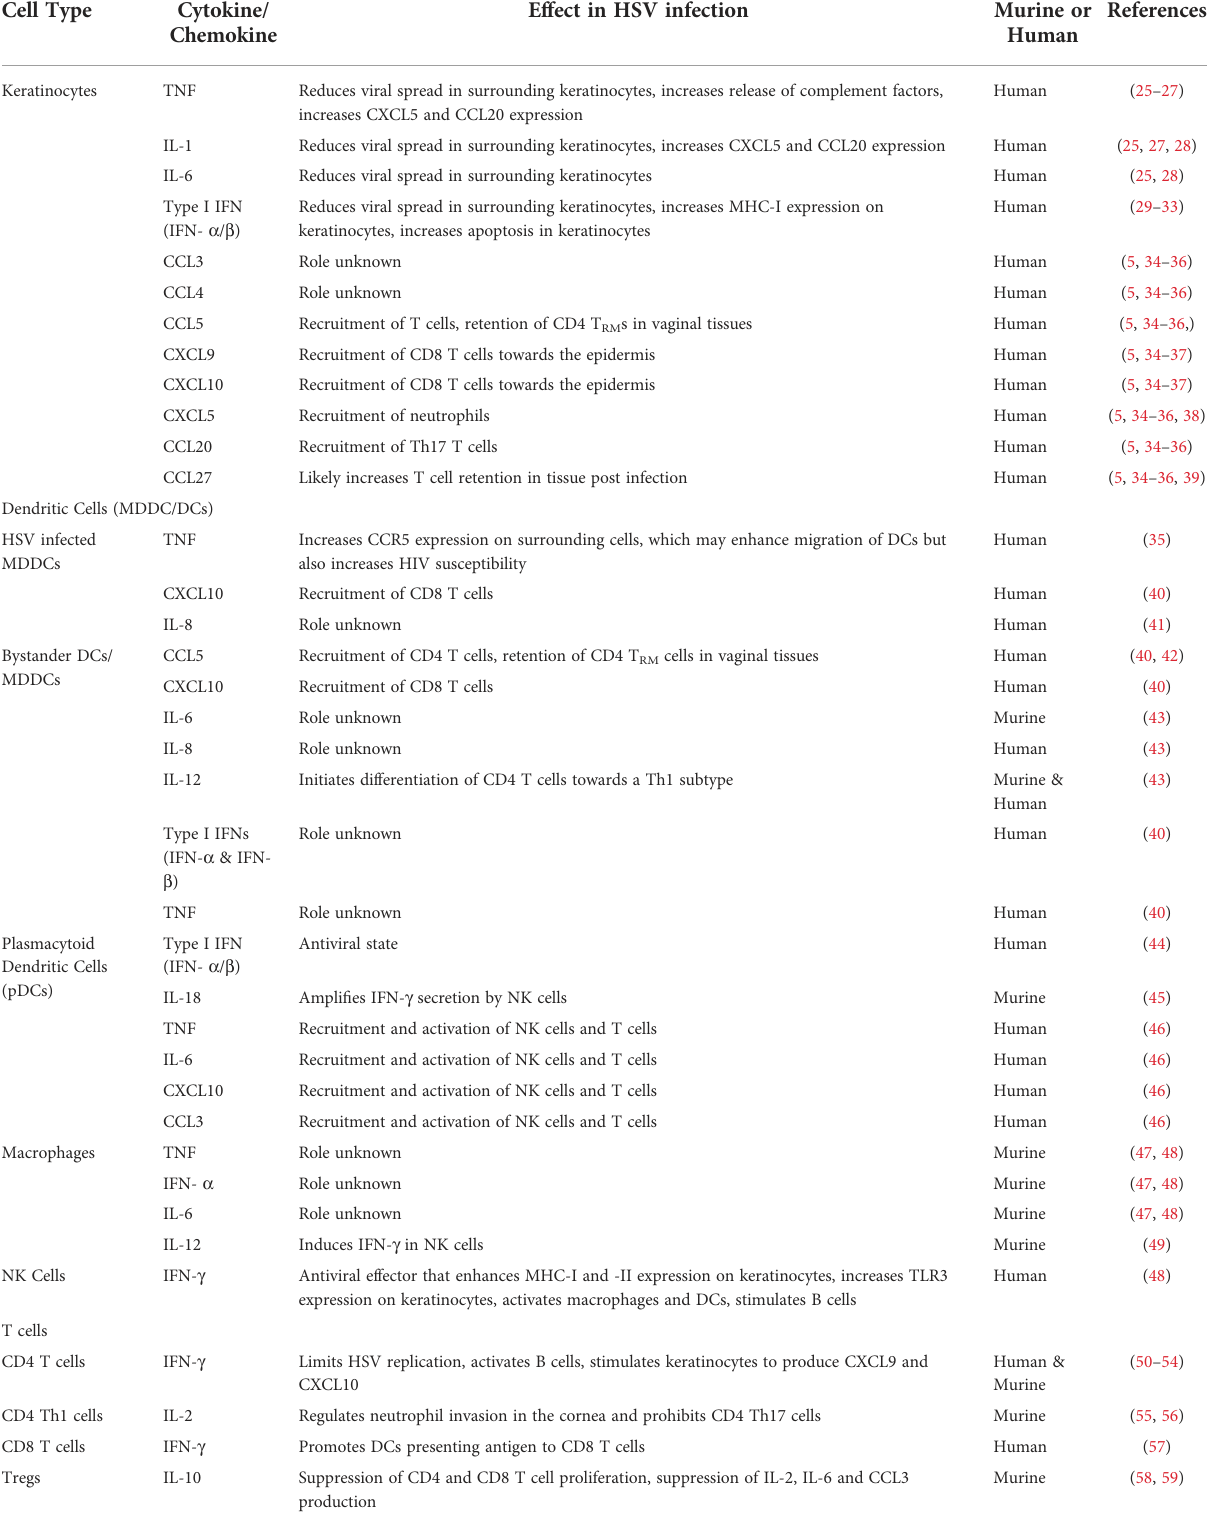
TABLE 1 Cytokines and chemokines produced during murine or human HSV infection and their subsequent role in immunopathogenesis. Cell